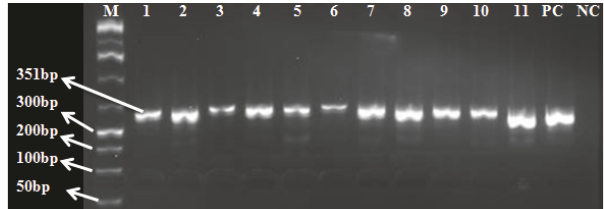
Figure 4: RT-PCR products visualized under UV transilluminator showing nucleoproteingeneamplicons whereMis theDNAmarker, 1-11 samples on gradient PCR. 1-6 is Kenya PPRV Goat Wajir; 7-11 is Kenya PPRV Camel Mandera, NC is negative control, and PC is positive